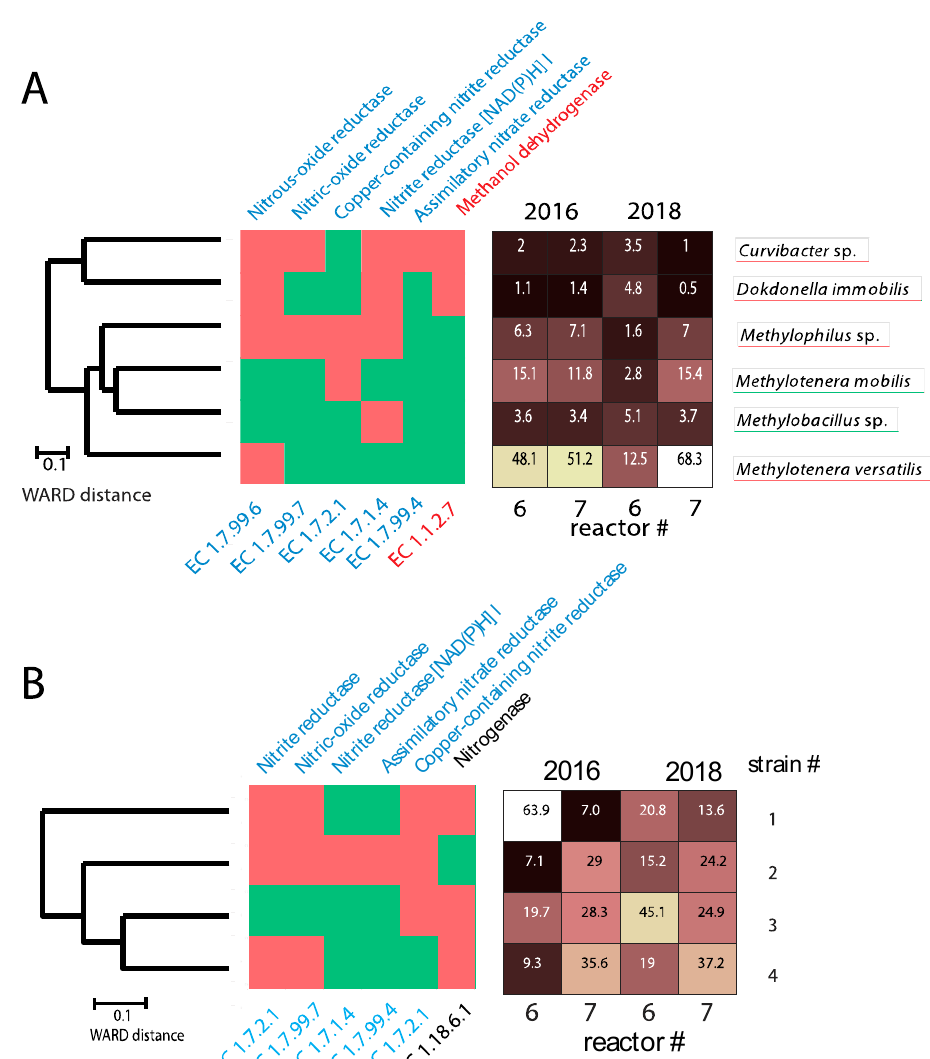
Figure 4. Gene content relatedness and distribution of species bins ( A ) and M. versatilis strains ( B ). The dendrograms represent the relatedness of the genomes / strains based on the total gene content with the color code indicating the presence (green) and the absence (red) of central genes encoding for searched enzymes. Genes important for denitrification are highlighted in blue, while the gene important for methanol utilization is marked in red, and the gene important for nitrogen fixation in black. The percentage of the species / strains within each reactor is also shown. The analyses are based on a total of 8 biofilms, two from each sampling point, with the mean values being presented.